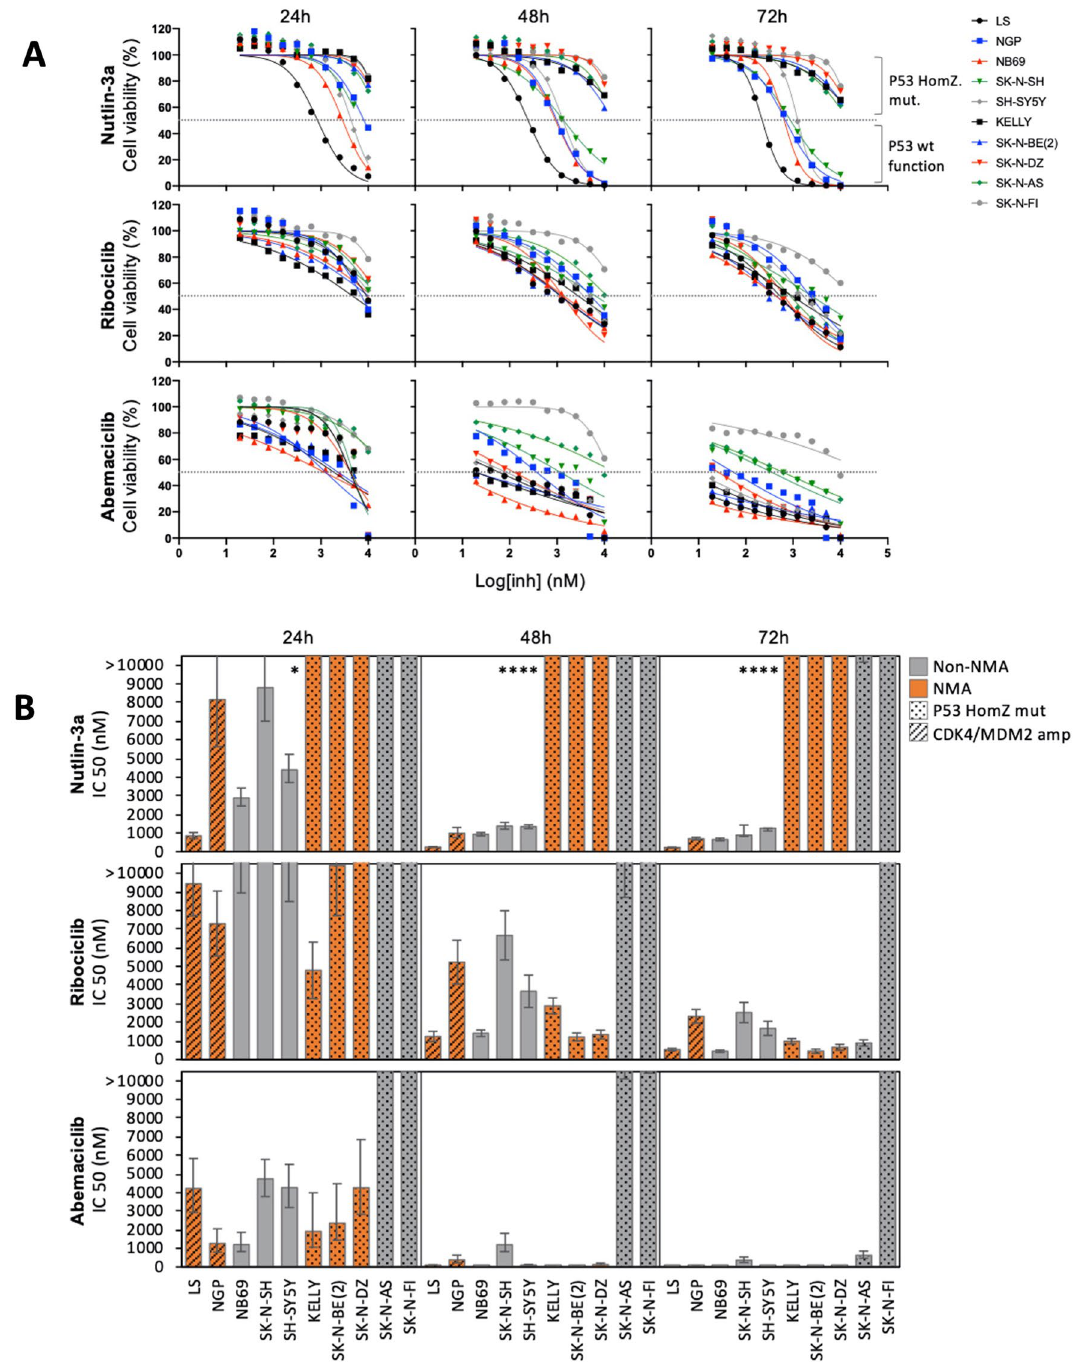
Figure 4. Neuroblastoma cell line response to MDM2i or CDK4/6i. ( A ) Normalized cell viability after treatment with Nutlin-3a (upper panels), ribociclib (middle panels), and abemaciclib (lower panels) for 24, 48, and 72 h. ( B ) IC50 values calculated after 24, 48, and 72 h of treatment. The bars represent the 95% CI for each IC50 value with statistical significance indicated as follows: * p < 0.01, ** p < 0.001, *** p < 0.0001, and **** p <